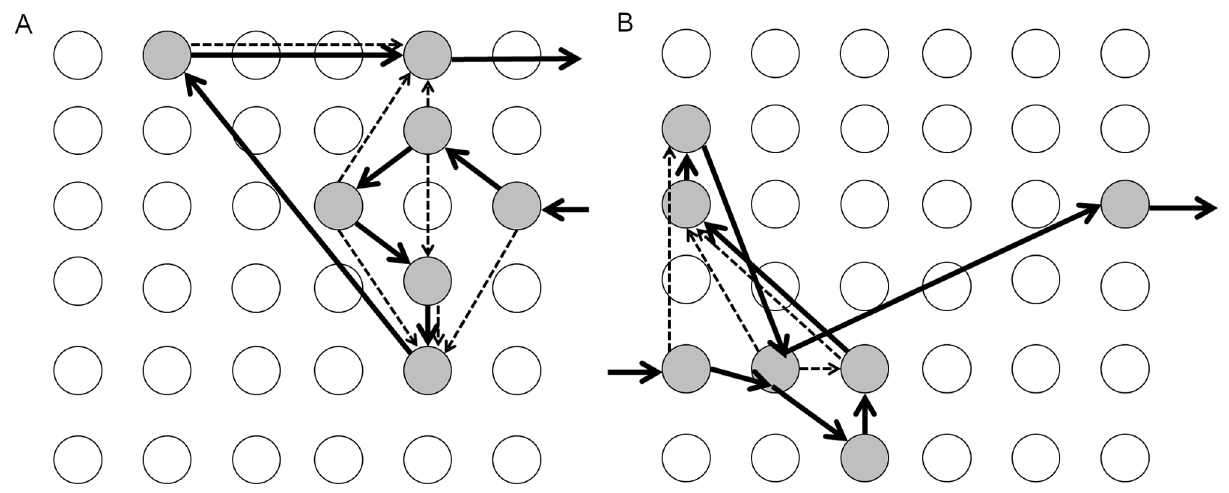
Figure 2. Examples of foraging bouts and pollen movement. Each circle indicates experimental flowers. Solid arrows indicate foraging movements of swallowtail butterfly (A) and hawkmoth and gray circles are visited flowers. Dashed arrows show pollen movement from donors to